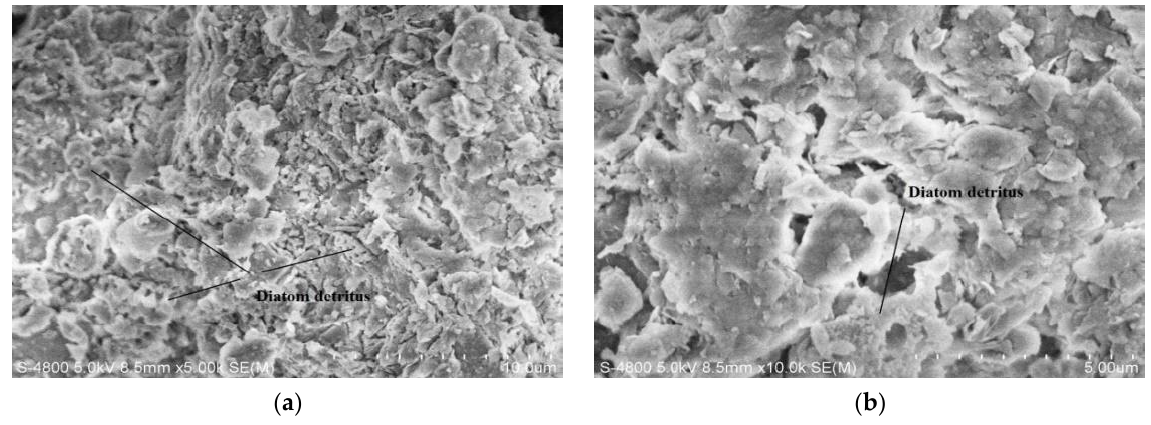
Figure 4. SEM results of diatomite soil. ( a ) 5000 times; ( b ) 10,000 times. Through the X-ray diffraction test, the elemental composition of the diatomite soil is